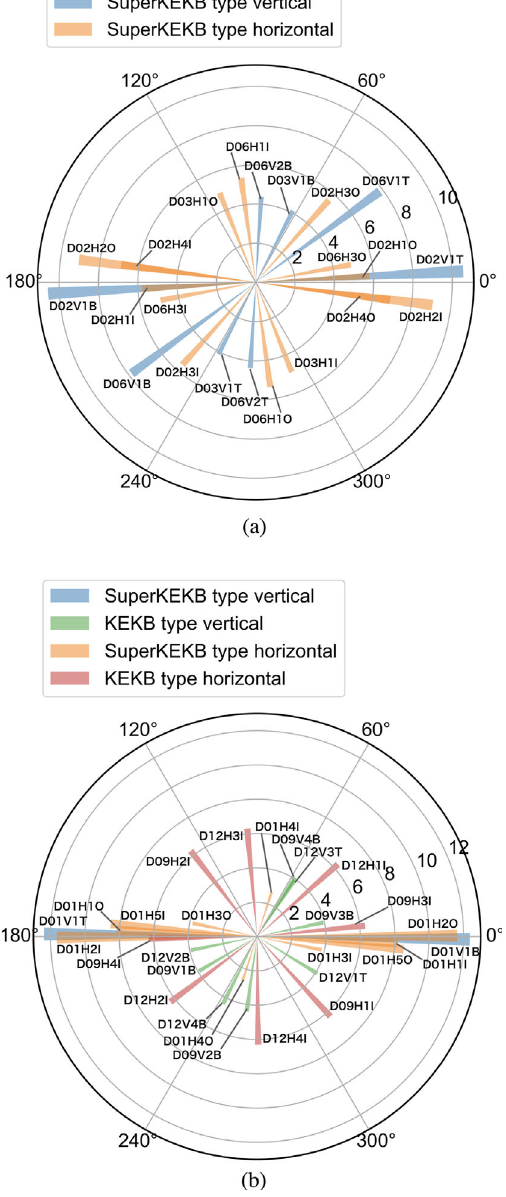
FIG. 3. Location of collimators in phases of the betatron oscillation for (a) LER and (b) HER. The angular coordinates refer to the phase advance to QC1RP in LER or QC1LE in HER, which are the closest final focusing magnets to IP; 0 and 180° refer to the phase in the QC1RP or QC1LE. The radial coordinates refer to the square root of the horizontal or vertical beta function at each horizontal or vertical collimator (unit: m 1 = 2 ), respectively. T, B, I, or O in the collimator names refer to the location of the jaw (top, bottom, inner, or outer side in the main ring,